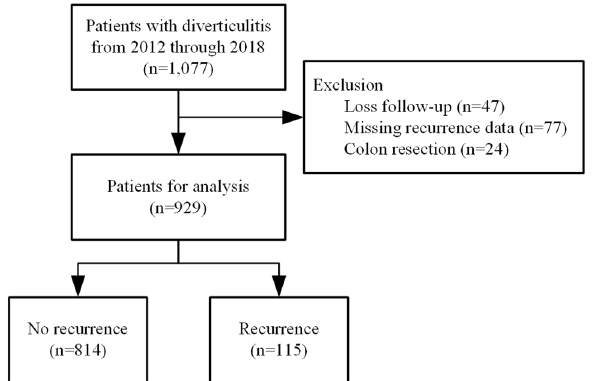
Figure 1. The study